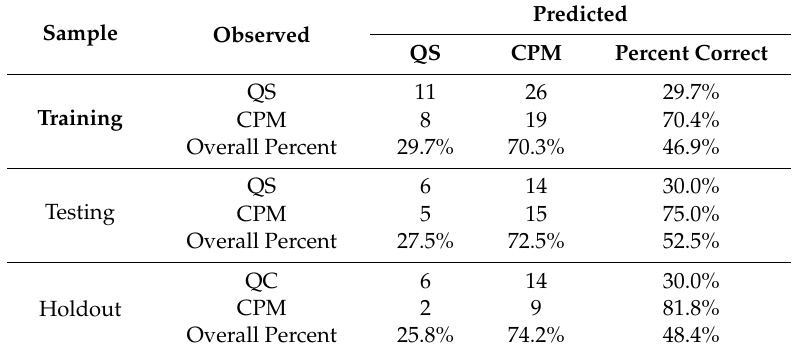
Table 9. Validated classification of predicted observed outcome from the multilayer